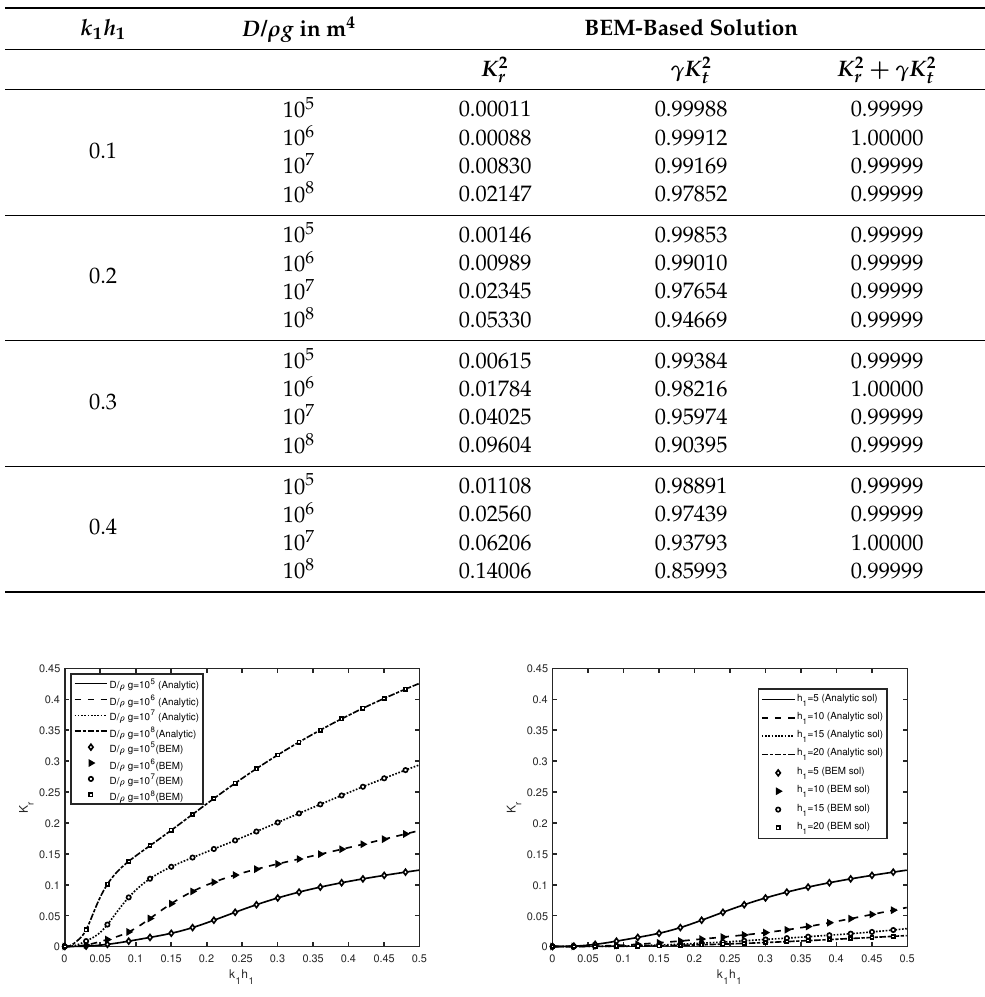
Table 1. Energy identity as in Equation (31) for waves scattering by semi-infinite floating flexible plate in finite water depth case.